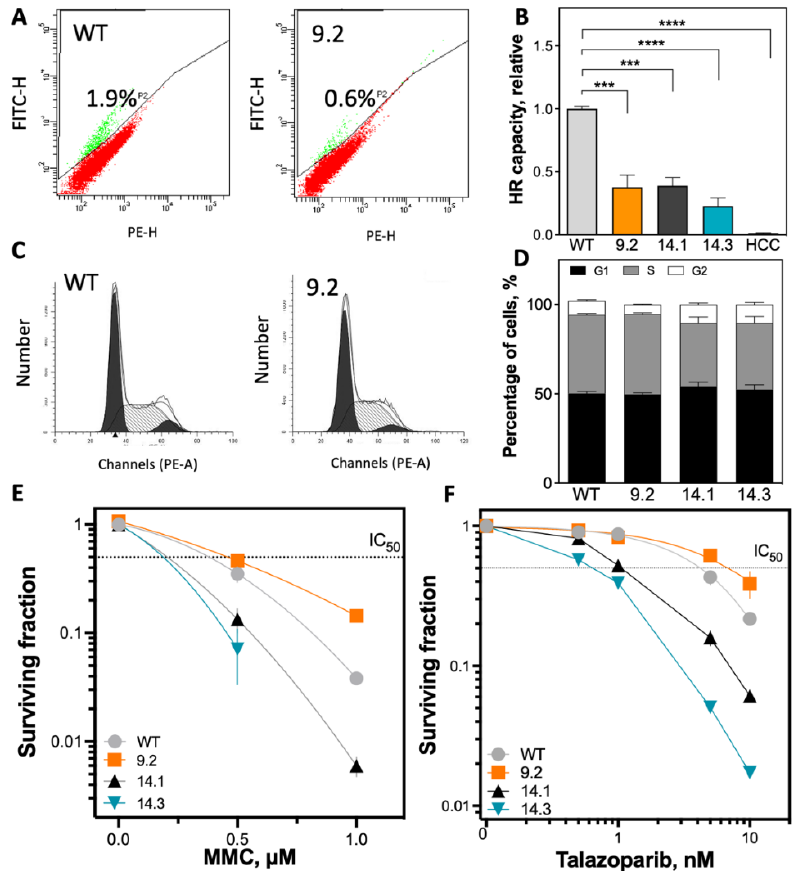
Figure 2. Significant reduction in HR capacity is not reflected by decreased survival after MMC treatment and PARP1 inhibition. ( A , B ) BRCA1 mutant MCF7 clones showed significantly reduced HR capacity in the plasmid reconstruction assay. Cells were transiently transfected with the pDR-GFP plasmid and HR-competent cells (GFP-positive) were detected by flow cytometry. The determined HR capacities were normalized to the MCF7 WT cell line. The BRCA1 -deficient cell line HCC1937 served as negative control. ( C , D ) No differences were detected in cell cycle profiles among BRCA1